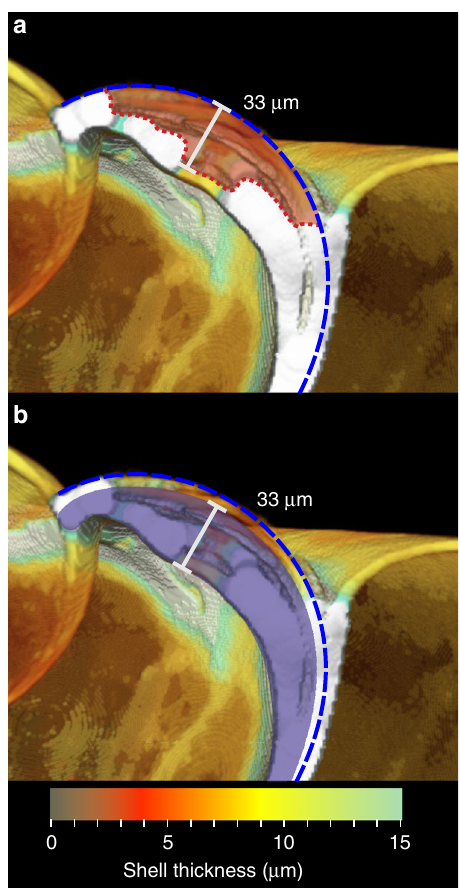
Fig. 4 Assessment of shell loss and thickening. Cross-section as Fig. 3c with blue dashed line indicating the original shell surface prior to damage/ dissolution. a The red shaded area indicates shell thickness lost between the original shell surface and the current shell surface (red dotted line). b The blue shaded area indicates shell thickening. Assuming an original shell thickness of 8 μ m, this specimen has thickened the shell to a maximum of 33 μ m at this